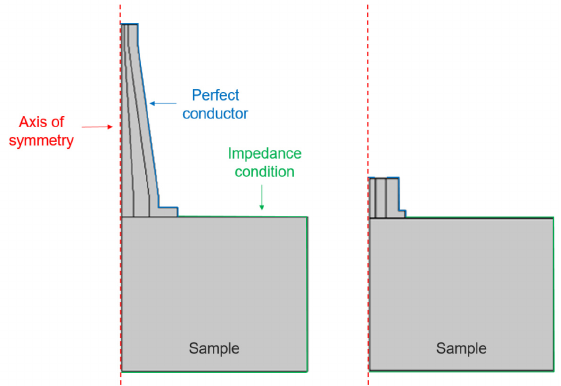
Figure 4. Built geometries and associated boundary conditions.